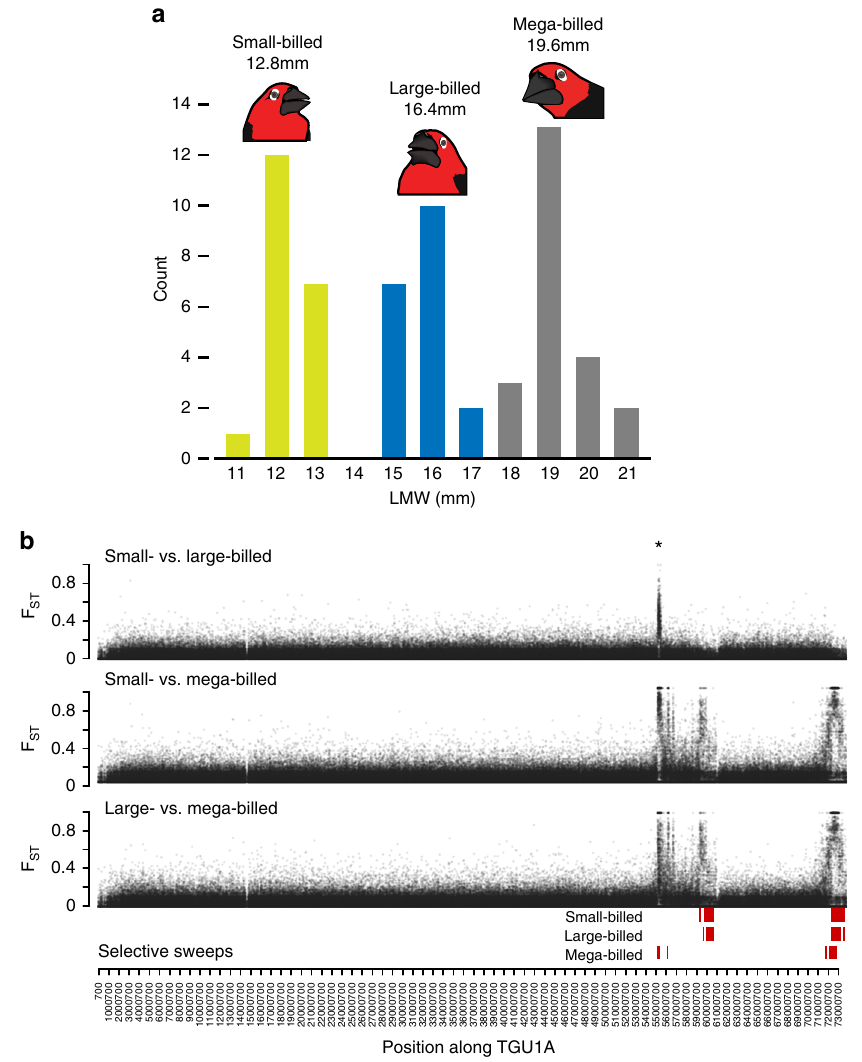
Fig. 1 Variation in bill morphology and genetics in Pyrenestes ostrinus . a Lower mandible width (LMW) measurements identify three bill morphs (average LMW per morph is indicated) b Pairwise comparisons of genetic differentiation ( F ST ) among the three bill morphs along chromosome 1A (TGU1A) in 200 bp windows. Red bars indicate the genomic regions of predicted selective sweeps for each bill morph. The candidate region is denoted with an asterisk